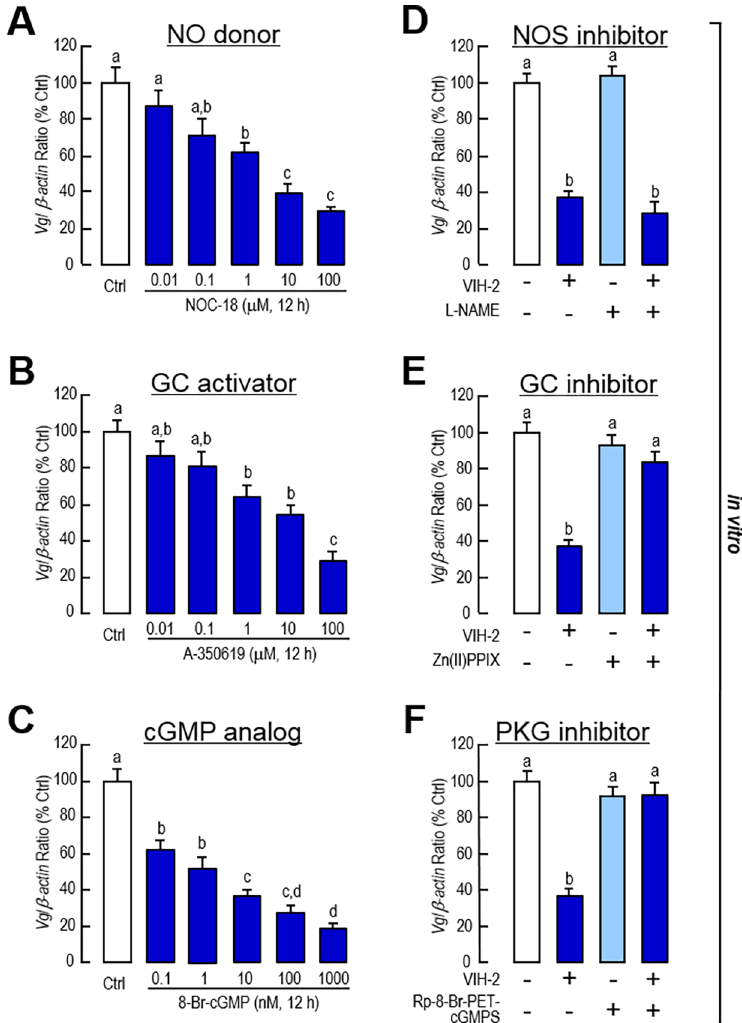
Fig 3. Involvement of cGMP-dependent signaling in VIH-2 suppressed Vg mRNA expression in the hepatopancreas of L . vannamei . A-C: The effects of the NO donor (A), the GC activator (B) and the cGMP analog (C) on Vg mRNA expression in shrimp hepatopancreatic cell cultures. The hepatopancreatic cells were incubated for 12 h with increasing doses of NOC-18 (0.01–100 μ M), A-350619 (0.01–100 μ M) or 8-Br-cGMP (0.1–1000 nM). D-F: Effects of NOS inhibitor (D), GC inhibitor (E) or PKG inhibitor (F) on VIH-2-inhibited Vg mRNA expression in shrimp hepatopancreatic cell cultures. The hepatopancreatic cells were incubated for 12 h with VIH-2 (1 μM) in the presence or absence of L-NAME (300 μM), Zn(II)PPIX (5 μM) or Rp-8-Br-PET-cGMPS (5 μM). In this study, the data presented are expressed as the mean±S.E. (n = 4). Experimental groups denoted by the same letter represent a similar level ( P > 0.05, ANOVA followed by Fisher’s LSD